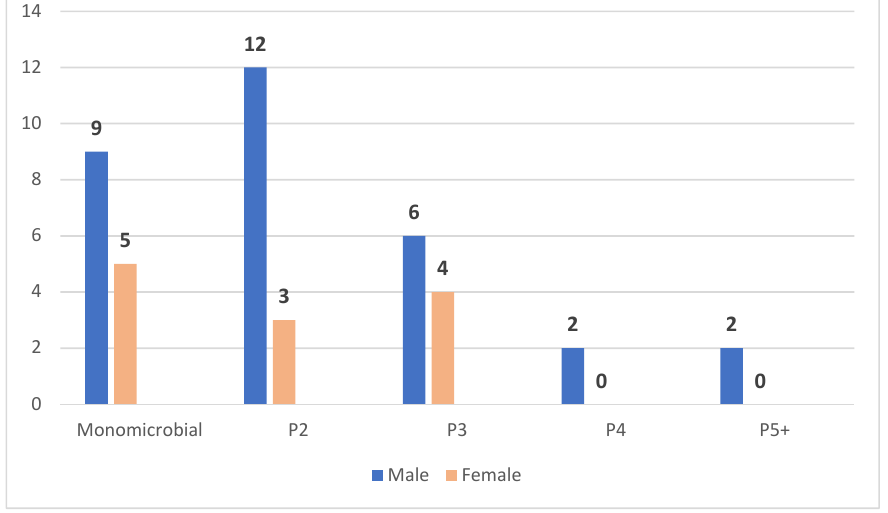
Figure 1. Mono and Polymicrobial infections and DFU patients’ gender. P2: polymicrobial infection colonized by 2 microorganism; P3: polymicrobial infection colonized by 3 microorganism; P4: polymicrobial infection colonized by 4 microorganism; P5+: polymicrobial infection colonized by 5 or more microorganism. Results for cigarette smoking and mono ‐ /polymicrobial infections are shown in Figure 2. For monomicrobial infections, 19% ( n = 8) of patiets were smokers (S), 7% ( n = 3) were ex ‐ smokers (EX) and non ‐ smokers (NS), respectively. Regarding polymicrobial